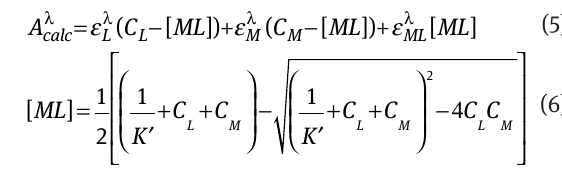
of solvent effect against covalent interaction in Pb 2+ - flavonoid complexes.